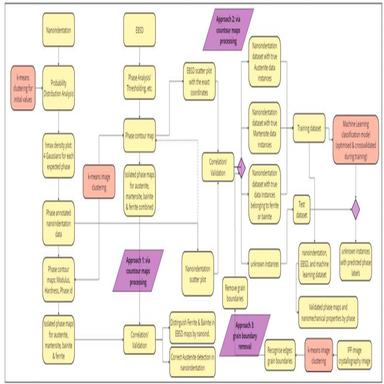
Mind map of the investigation: the workflow of meta-analysis of ex-situ produced nanoindentation and EBSD data was conducted within the same ROI.